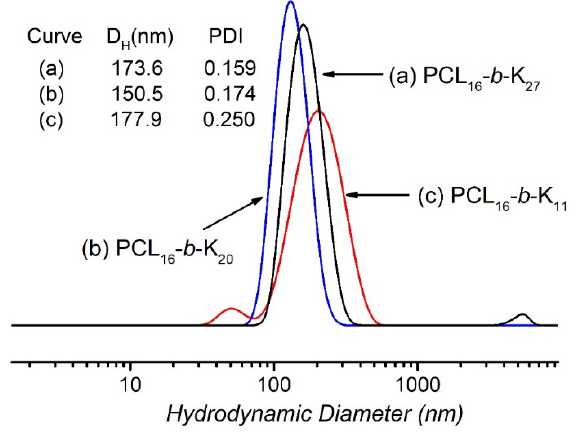
Figure 1. DLS study of ( a ) PCL 16 - b -K 27 , ( b ) PCL 16 - b -K 20 , ( c ) PCL 16 - b -K 11 diblock copolymer vesicles.